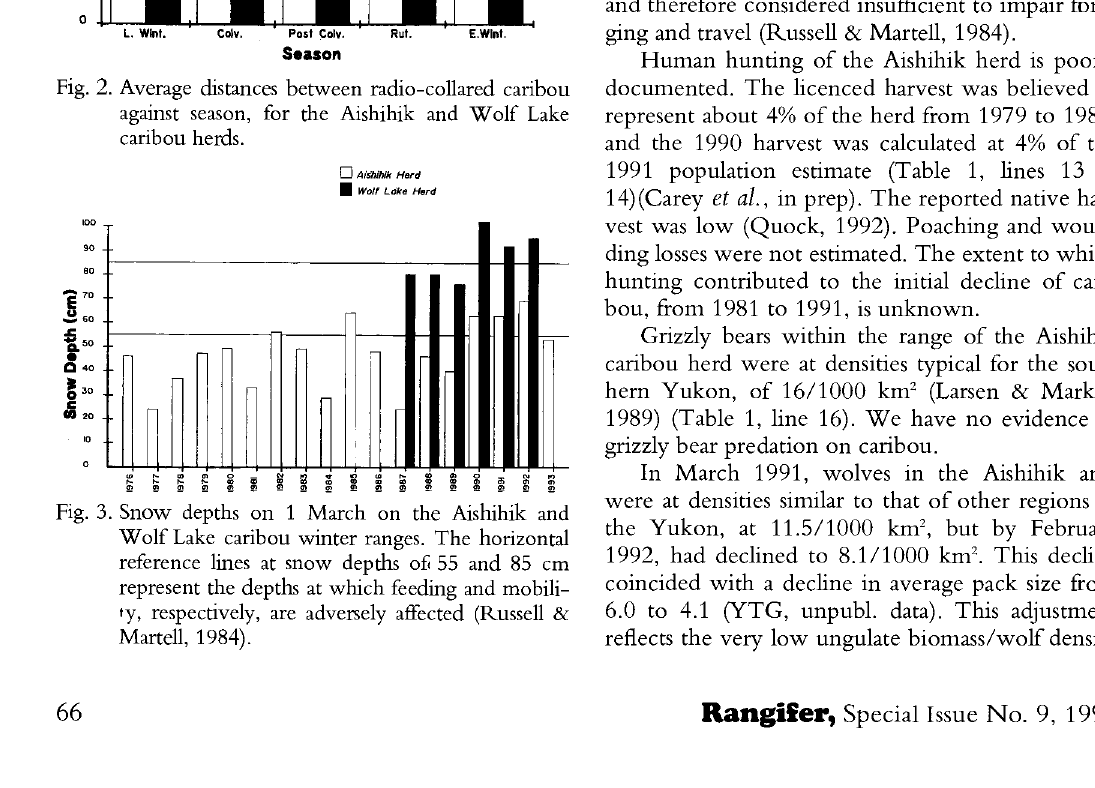
Fig. 3. Snow depths on 1 March on the Aishihik and Wolf Lake caribou winter ranges. The horizontal reference lines at snow depths of 55 and 85 cm represent the depths at which feeding and mobili ty, respectively, are adversely affected (Russell & Martell,